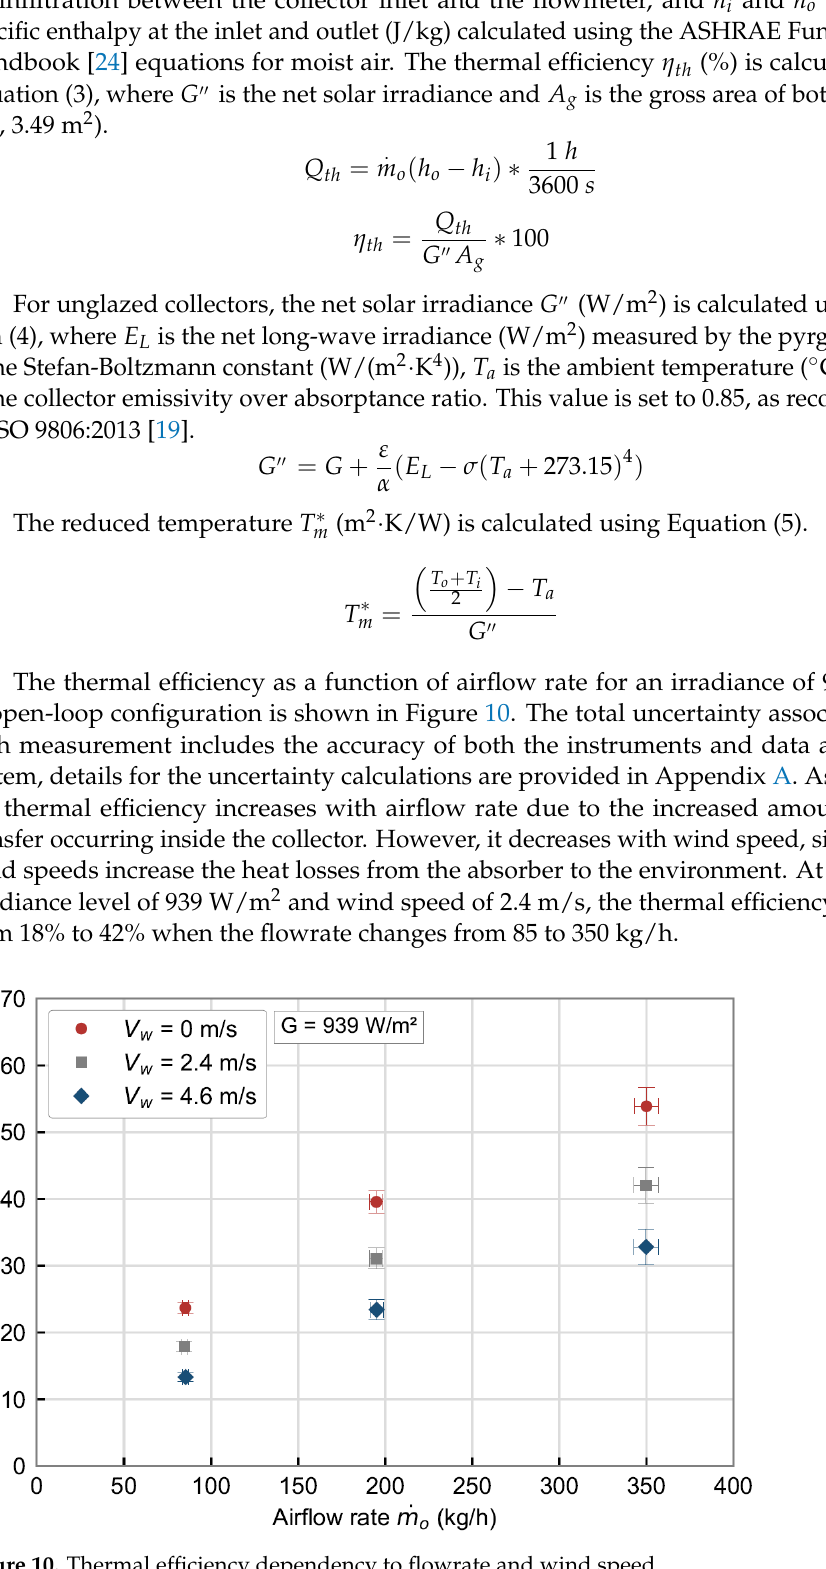
Figure 11. Temperature rise dependency to flowrate and wind speed.